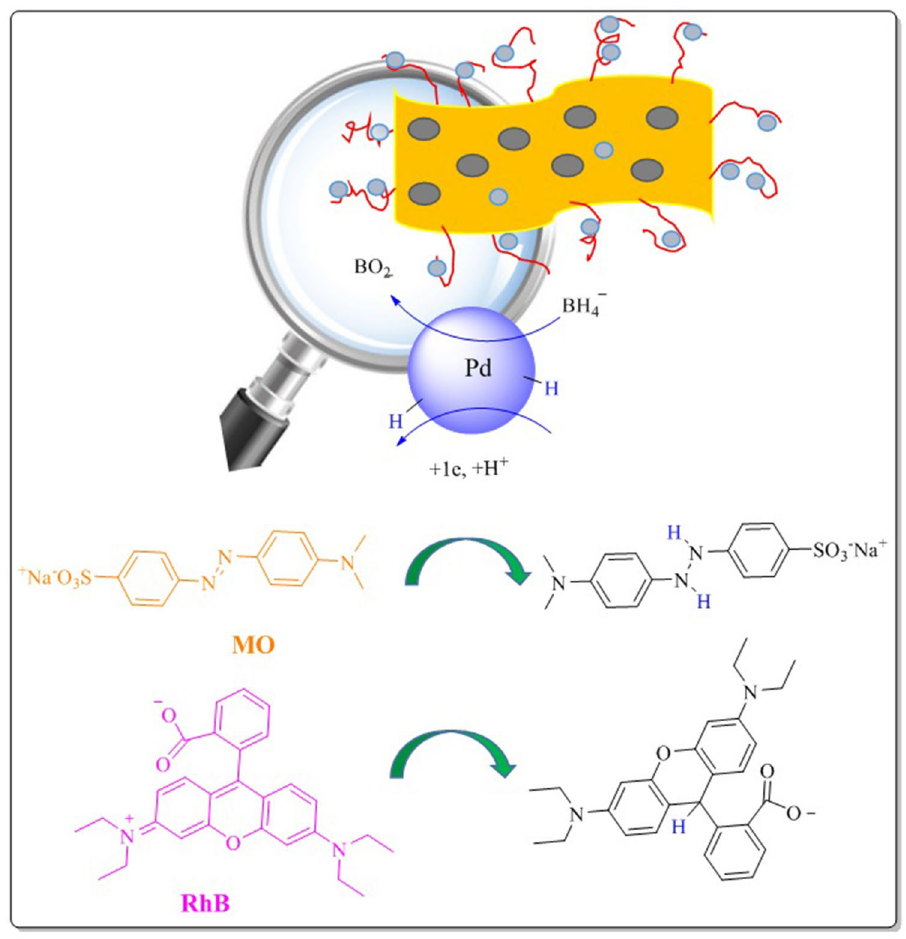
Figure 6. The plausible mechanism for dye